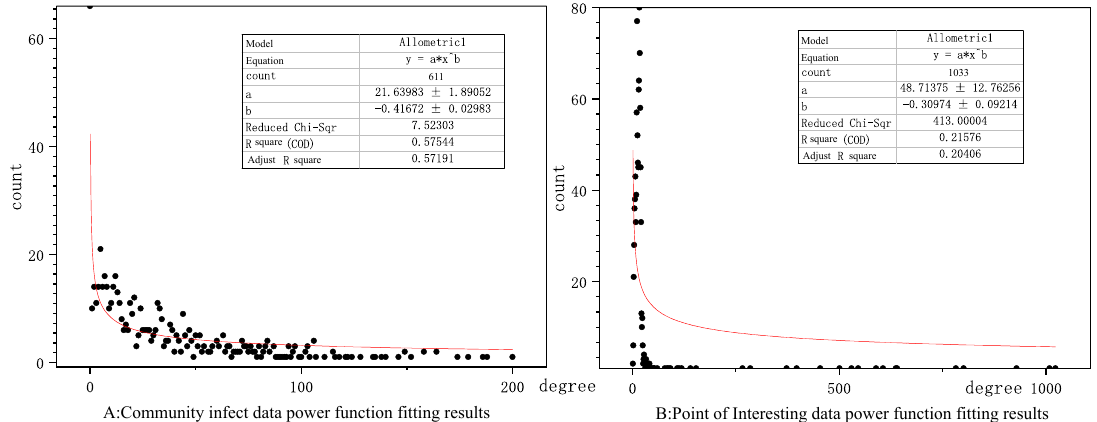
Figure 9. Power-function fit to the degree of a